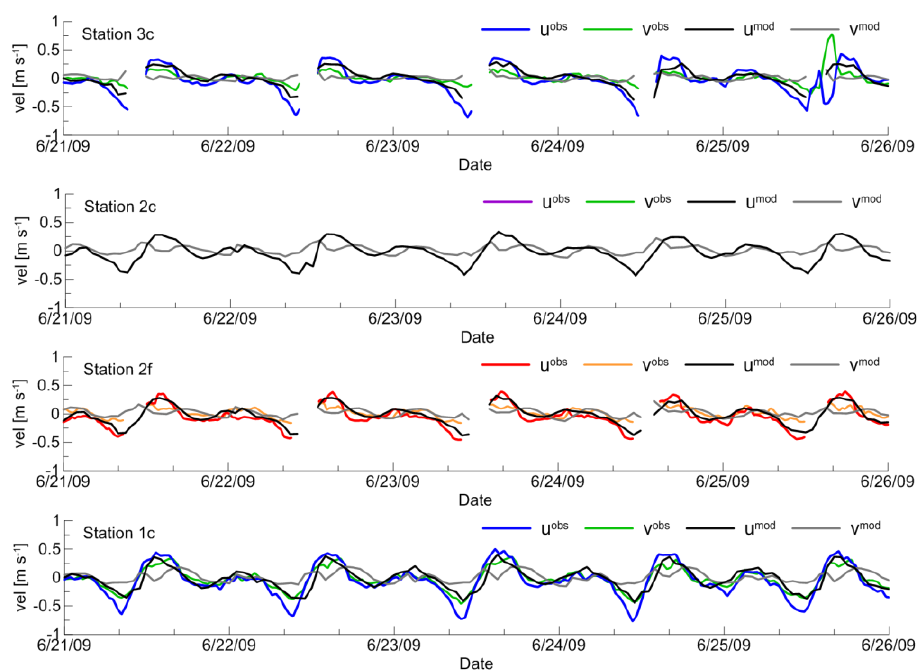
Figure 5. Comparison of bottom currents in Skagit tidal flats shown at stations 3c, 2c, 2f and 1c during June of 2009 as part of sediment model setup and calibration. ( u obs = observed east velocity component, v obs = observed north velocity component, u mod = modeled east velocity component and v mod = modeled north velocity component).